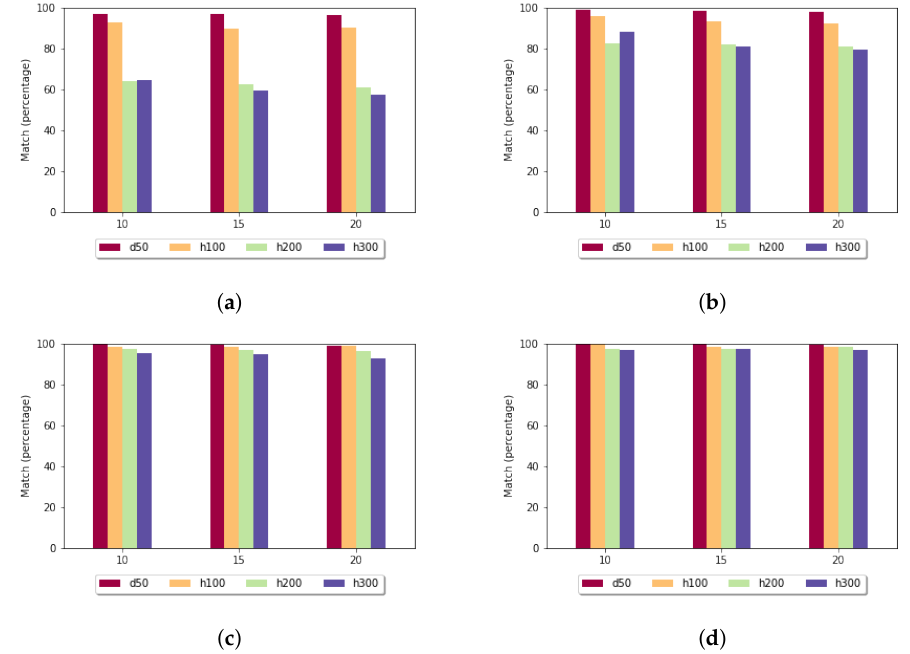
Figure 10. Exact match rate (y axis) depending on the size of the sample set (x axis) and length of the k-mers in the case of affine gap penalty: ( a ) k = 5; ( b ) k = 7; ( c ) k = 10; and ( d ) k =